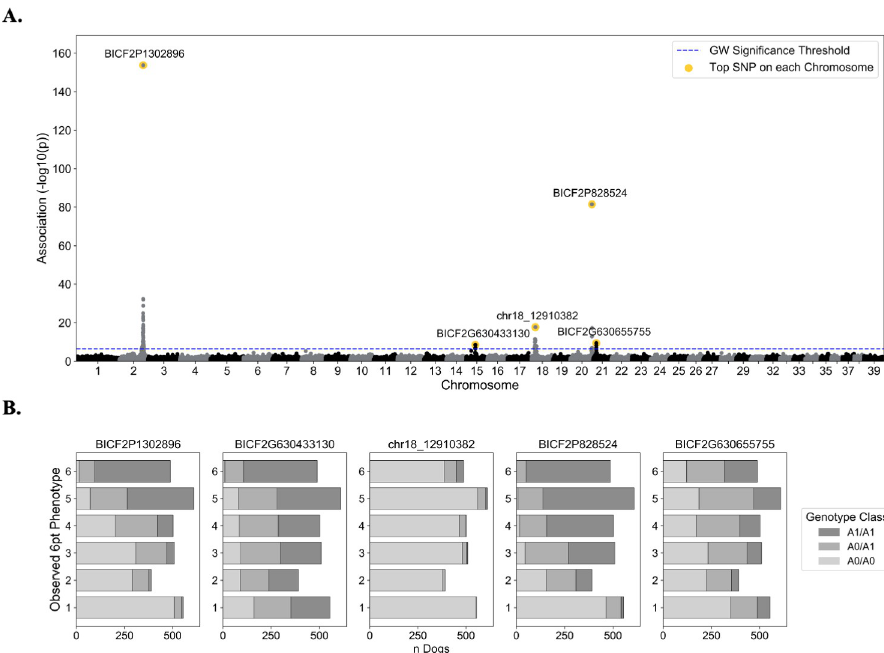
Fig 2. Quantitative coat pheomelanin intensity GWAS results. A. GWAS p-values are shown in a Manhattan plot for the autosomes (chromosome 1–38) and the X chromosome (chromosome 39). For each chromosome with one or more genome-wide significant markers, the top marker on the chromosome is highlighted in gold and labeled with its marker ID. The blue dashed line shows the minimum unadjusted -log 10 (p-value) for genome-wide significance using the Bonferroni correction: 6.56. B. Bar plots show the number of dogs with each phenotype value (1–6) for each genotype class at each of the top five GWAS markers. The genotype classes are coded according to the dosage of the red-associated alleles at each marker, which are listed in Table 1 as “Allele 1”.